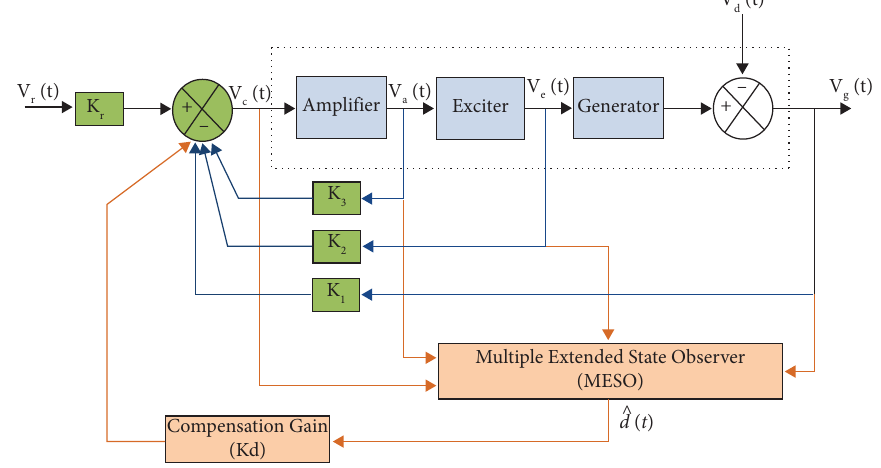
Figure 2: Schematic diagram of MESOBC for